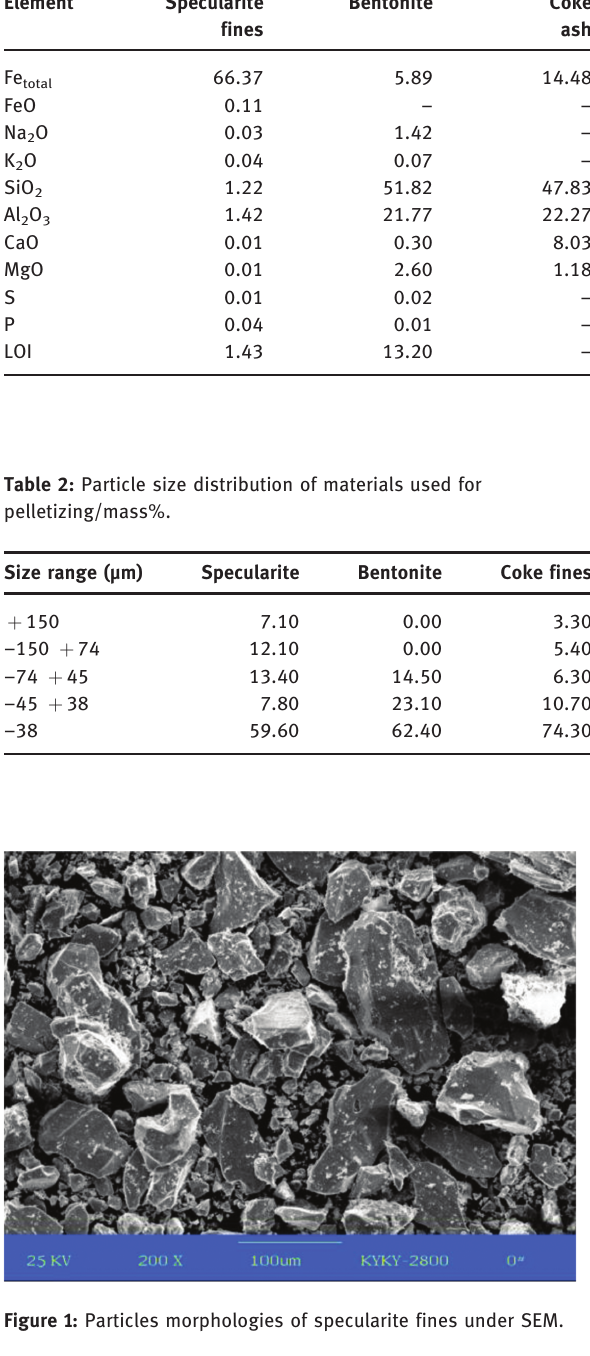
Table 1: Chemical composition of raw materials/mass%. Element